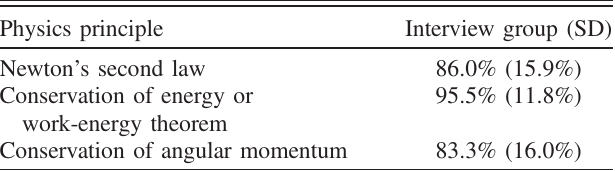
TABLE III. Average paired problem scores and standard deviations (SD) in one-on-one implementation